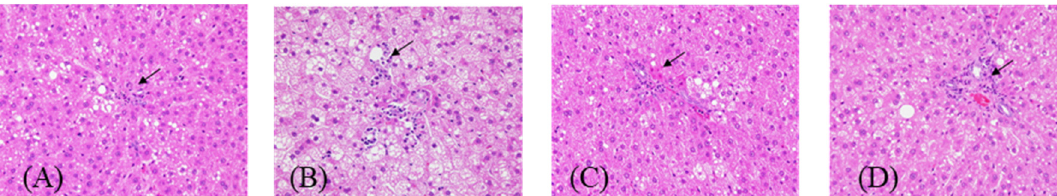
Figure 2. Histopathological changes of lime on liver in Wistar rats induced by high-fat diets. ( A : Control, B : HF, C : LEO-N, D : LEO-H) H&E stain, 400 × . Control ( C ): normal diet, HF: high-fat diet, lime essential oil normal dose (LEO-N): high-fat diet containing 0.744% lime essential oils, lime essential oil high dose (LEO-H): high-fat diet containing 2.232% lime essential